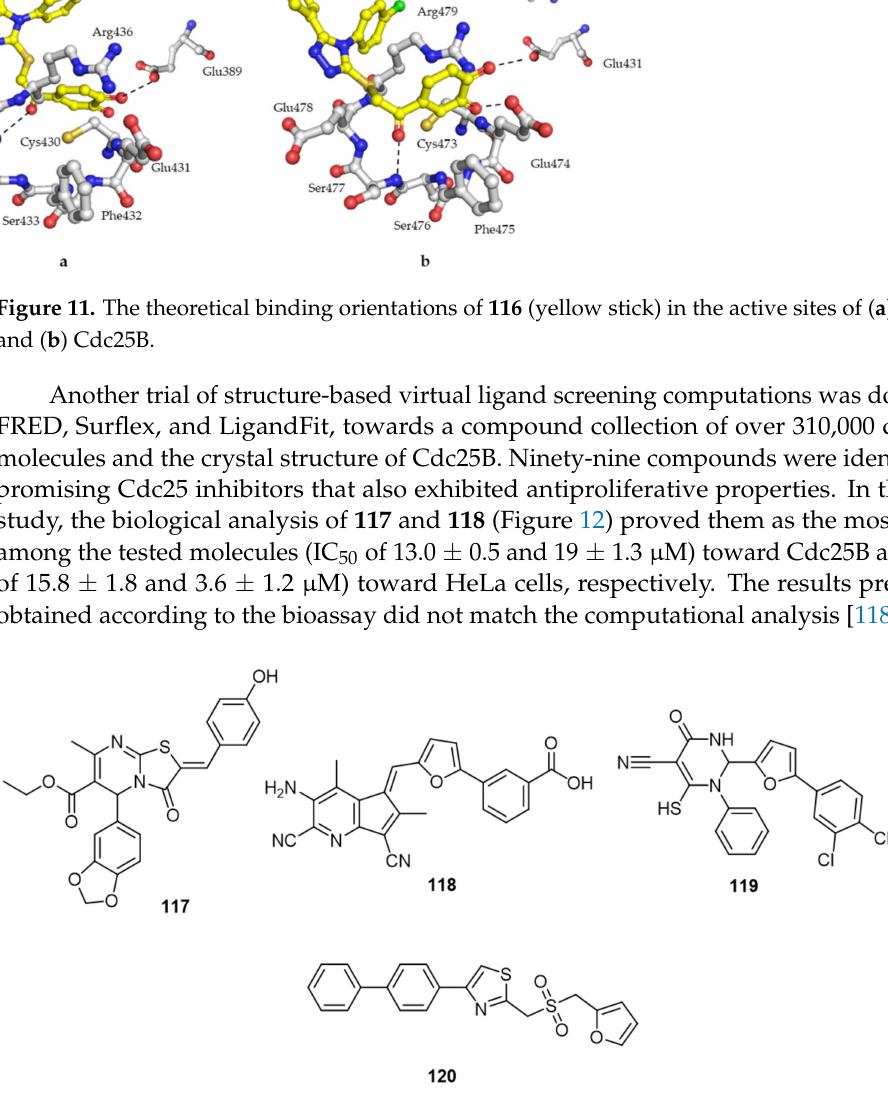
Figure 12. Chemical structures of compounds 117 , 118 , 119 and 120